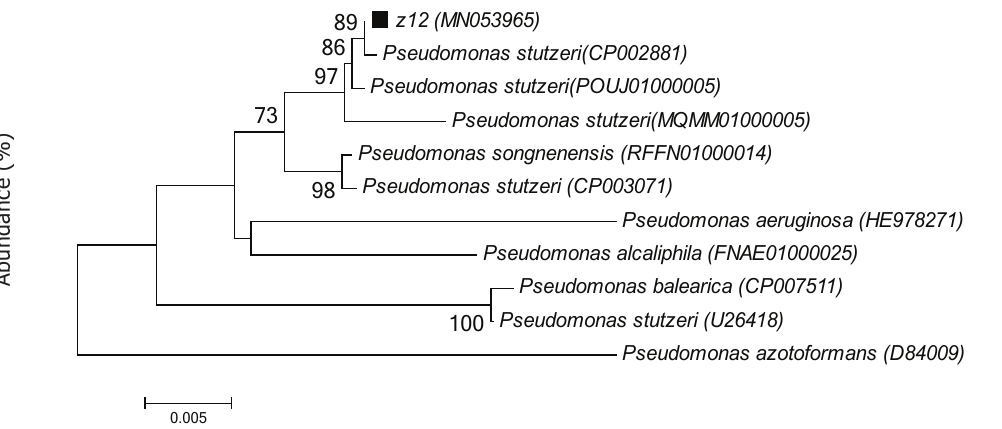
Fig. 2 – Phylogenetic tree constructed using the neighbor­joining method based on the 16S rRNA gene